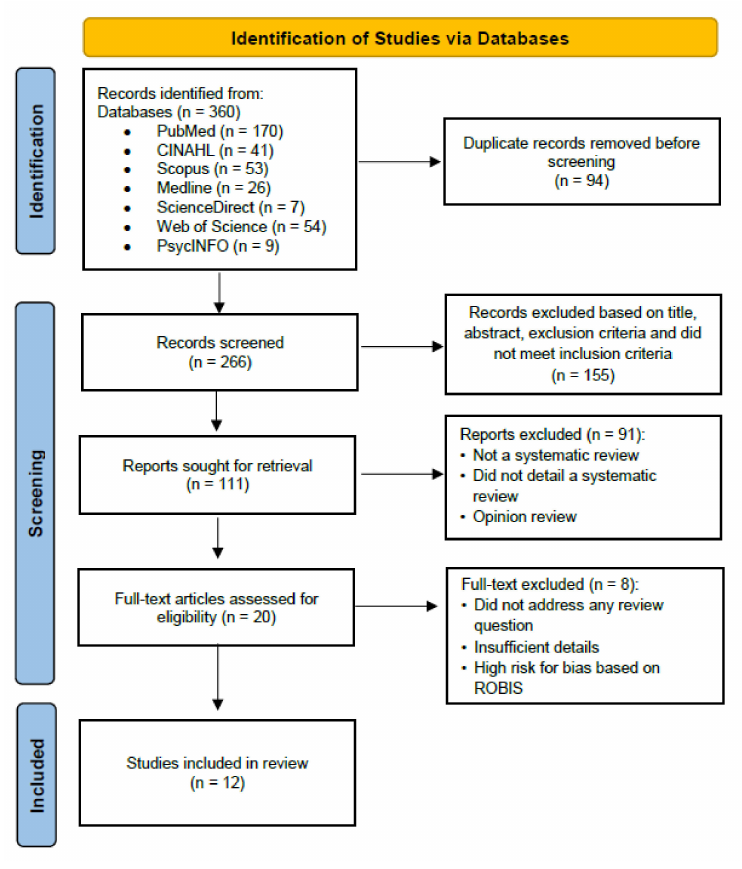
Figure 1. PRISMA